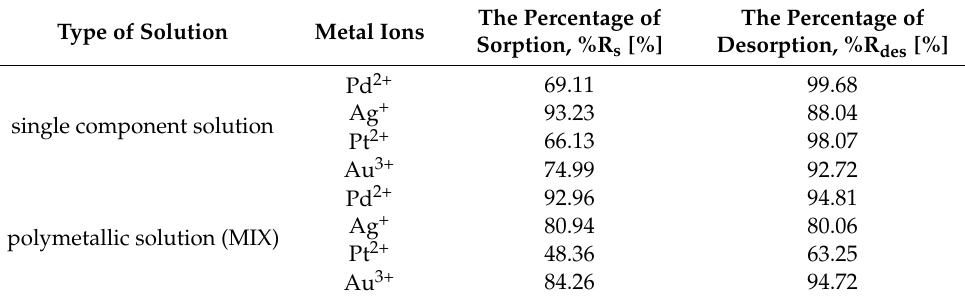
Table 4. The results of the recovery of precious metal ions (Pd 2+ , Ag + , Pt 2+ , and Au 3+ ) from single-component and polymetallic solutions using polymer membranes containing N,N' -bis(salicylidene)ethylenediamine. Type of